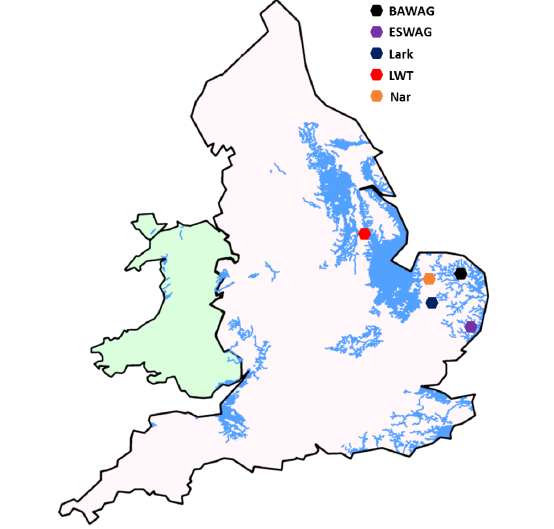
Fig. 1 . Map of England and Wales showing location of the five water abstractor groups included in the study. Blue shading represents areas under the management of internal drainage boards. Adapted from Venables et al. [date unknown]. BAWAG, Broadlands Agricultural Water Abstractor Group; ESWAG, East Suffolk Water Abstractor Group; LWT, Lincoln Water Transfer.